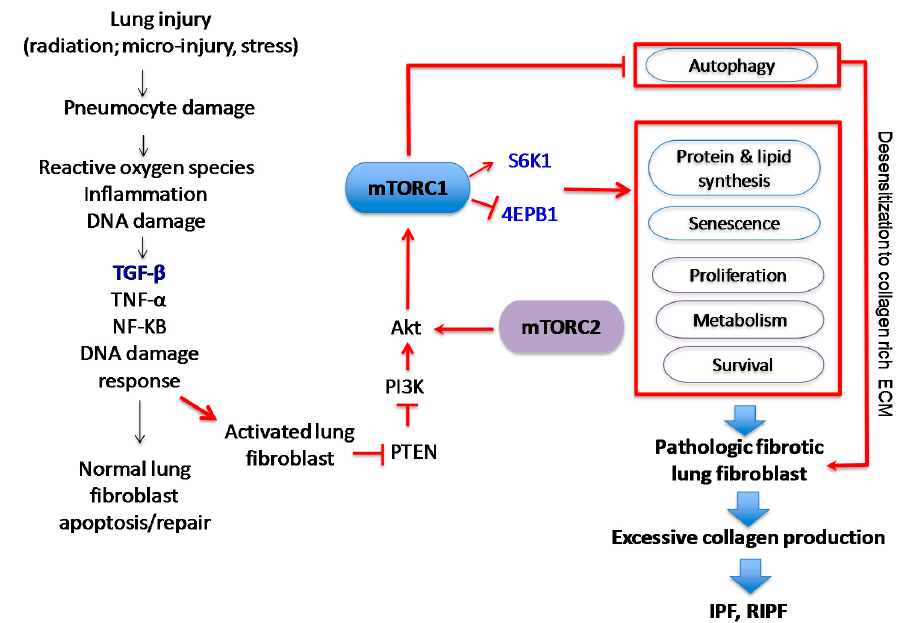
Figure 11. The role of mTORC1 and mTORC2 in the development and progression of idiopathic pulmonary fibrosis (IPF) and radiation-induced pulmonary fibrosis (RIPF). mTORC1 and mTORC2 are intricately involved in promoting mechanisms that favor activated lung fibroblast survival and relentless collagen production. mTORC1 inhibitors have been shown to modulate RIPF and bleomycin-induced pulmonary fibrosis, suggesting they may be effective mitigators in fibroproliferative lung disease. The arrows indicate positive regulation while T indicates the inhibition of the target molecule.